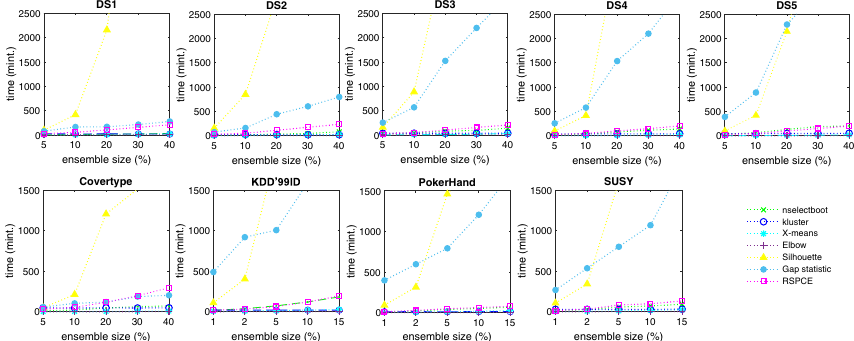
Fig. 7 Execution time (in minutes) of different methods against different data sizes. The plot is the average value of 20 random runs with the same data